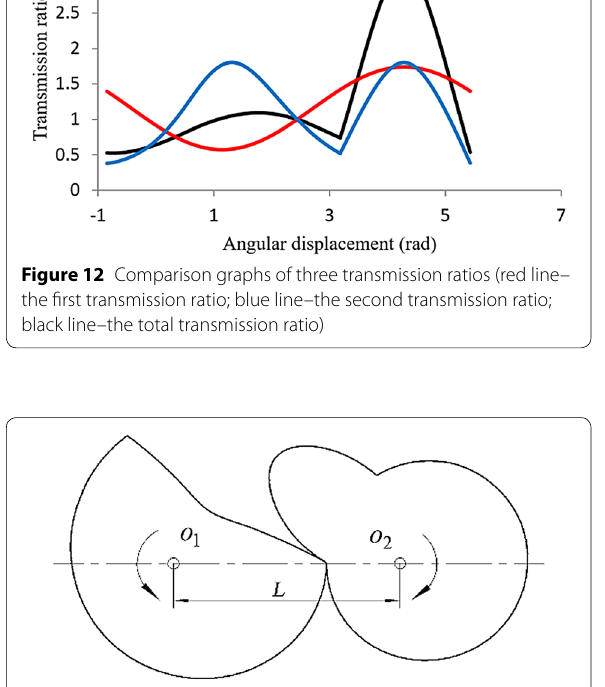
Figure 13 Pitch curve of secondary continuous unequal-amplitude combined gear